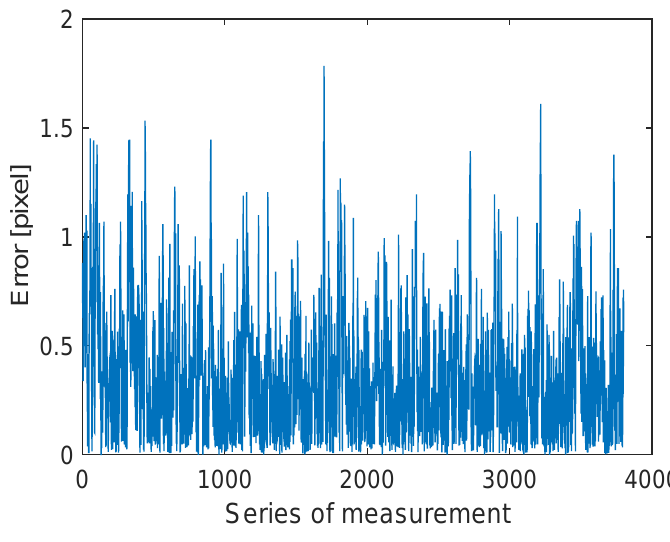
Figure 16. Measurement